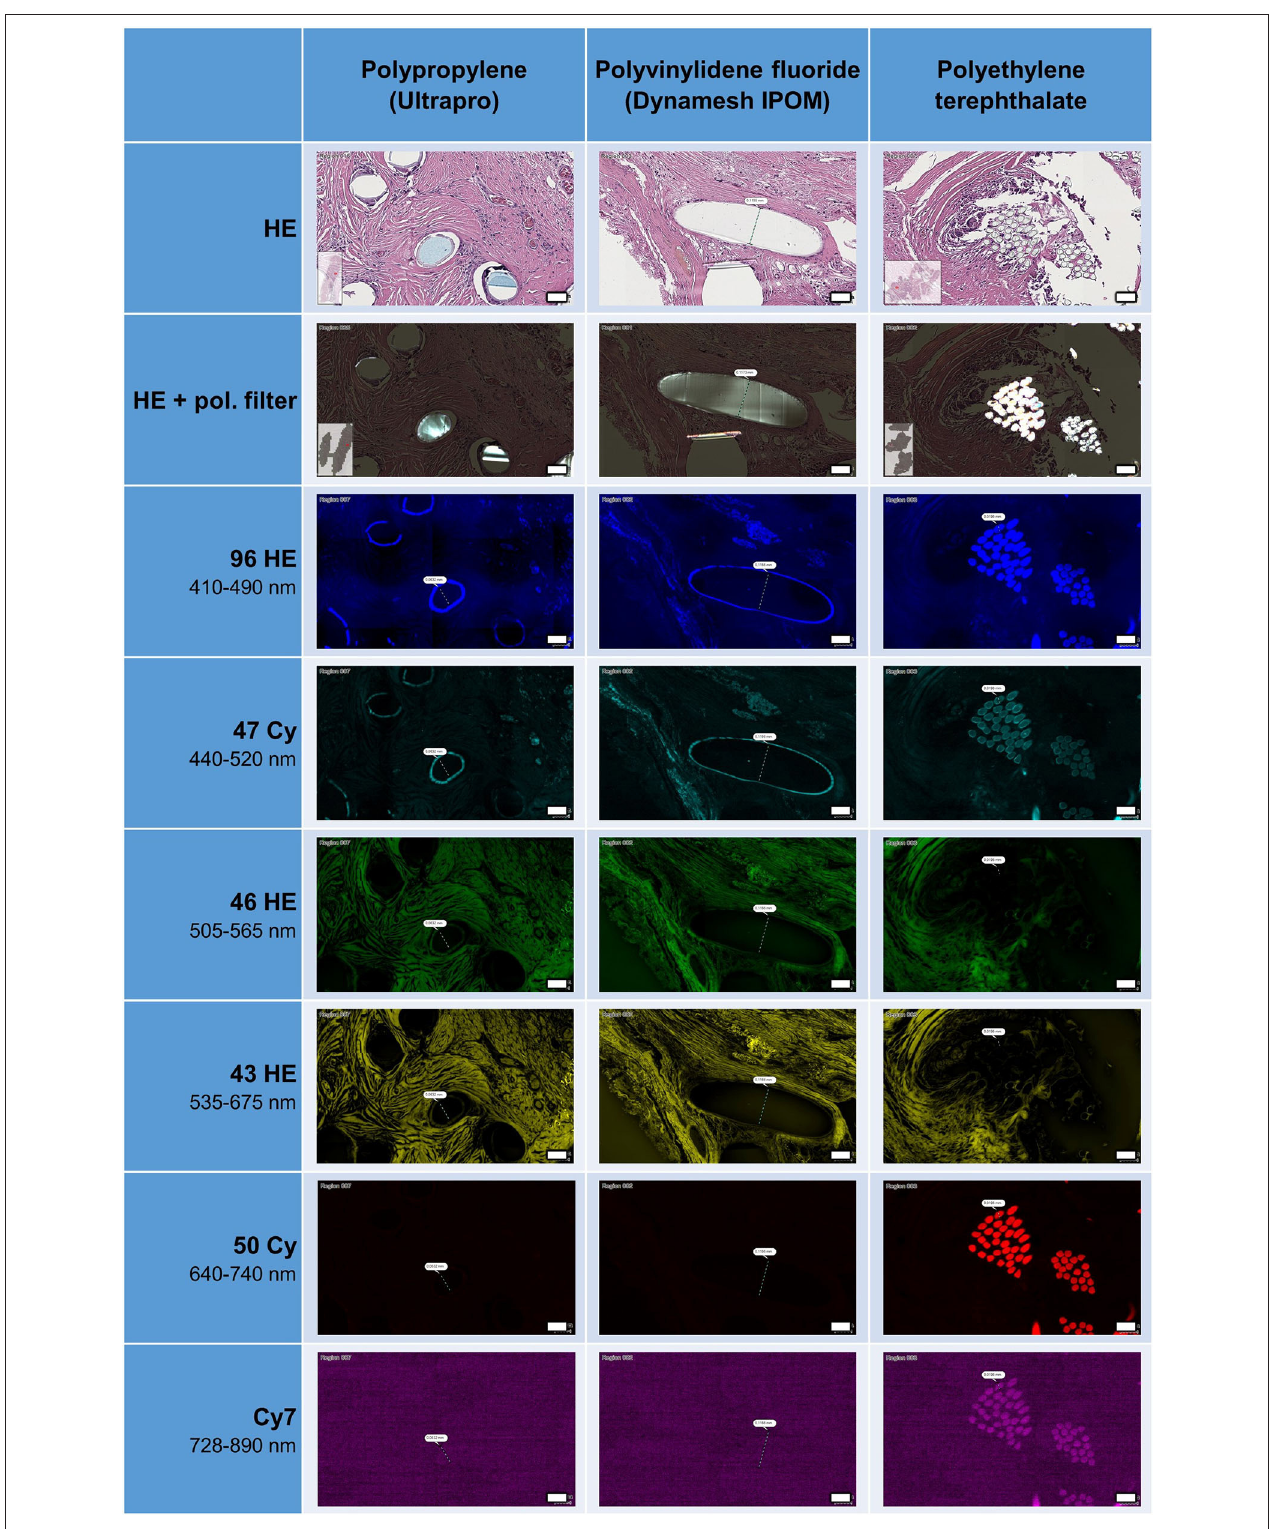
FIGURE 1 | Appearance of HE-stained meshes in bright field microscopy, with or without polarization filter, and with fluorescence microscopy. All polymers visible with pol. filter. Surface of PP and PVDF fibers visible as ring formation with autofluorescence at 410–520nm, whereas polyester fibers visible at 410–520 and at 640–890nm. Scale bars = 50 µ